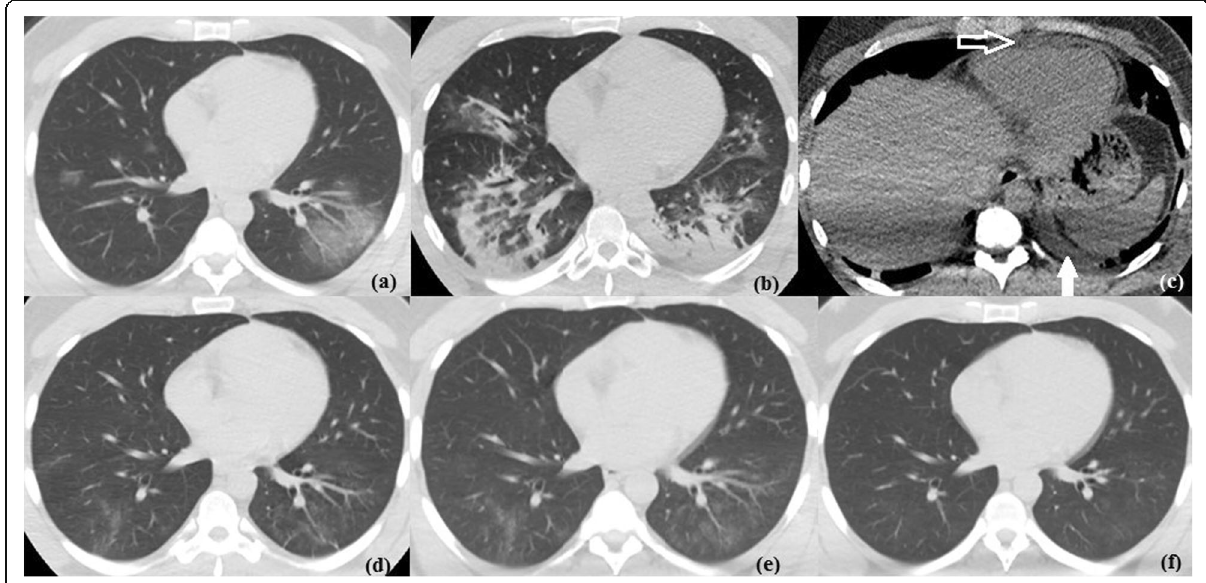
Fig. 5 Temporal CT changes in a 35-year-old male with COVID-19. a Initial non-contrast CT chest axial lung window showing multifocal bilateral predominantly peripheral patchy ground glass opacities with vascular thickening. b , c Follow up CT study after 7 days in axial lung and axial non- contrast mediastinal windows showing progressive course regarding the extent of lung involvement with bilateral predominantly peripheral patchy consolidation and air bronchogram associated with newly developed mild pericardial effusion (hollow arrow) and mild left pleural effusion (solid arrow). d – f Follow up images 16, 22, and 28 days respectively after initial CT showing gradual regressive course with only ill-defined faint GGO